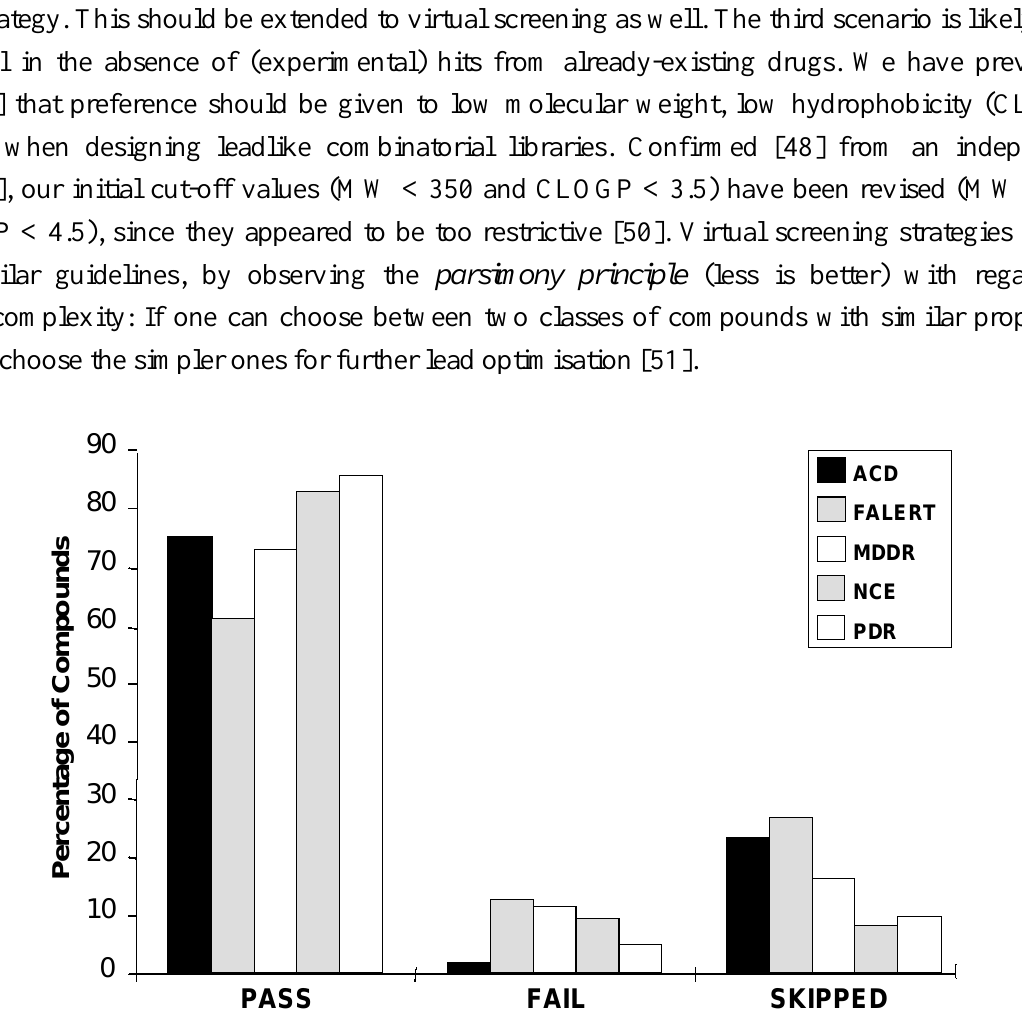
Figure 5. Comparative distribution of RO5 tests across different chemical databases: ACD, the Available Chemicals Directory, FALERT, Current Patents Fast-Alert, MDDR, MACCS Drug Data Report, NCE, New Chemical Entities, and PDR, the Physician’s Desk Reference (see [52] for details on these databases). The “skipped” column indicates molecules for which CLOGP could not be